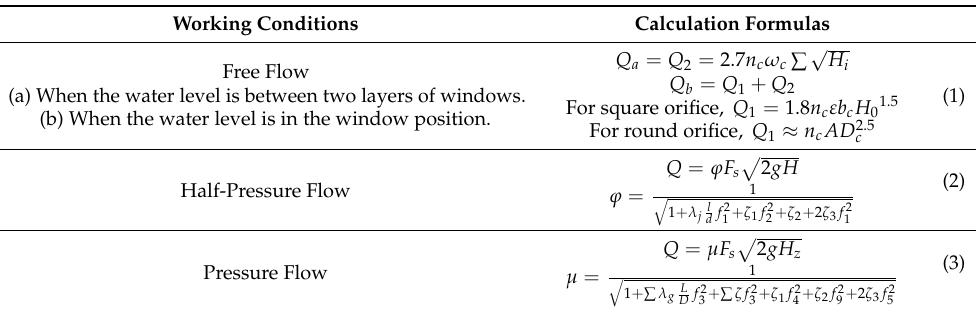
Table 1. Theoretical calculation formulas of “window-type draining well plus tunnel/draining pipe” flood-discharging